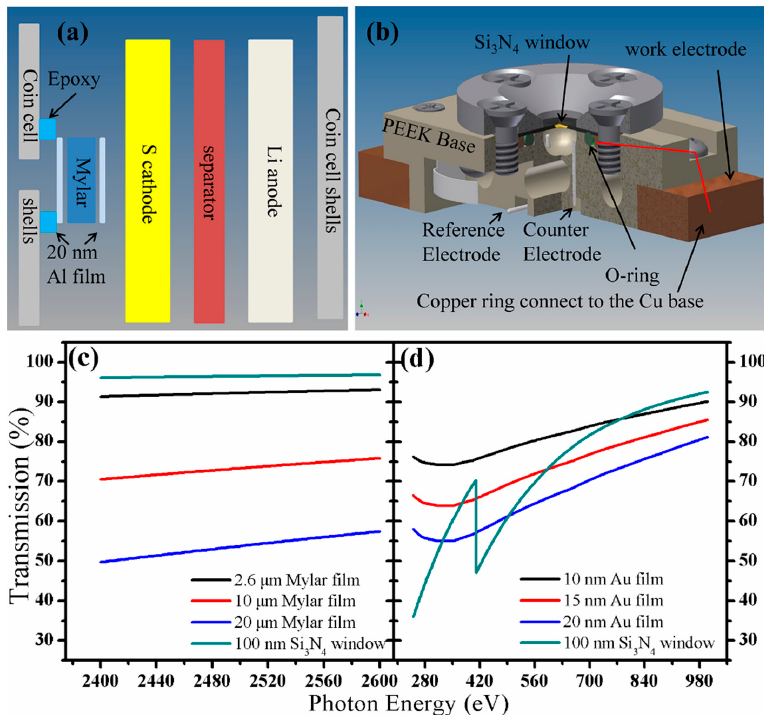
Figure 3. The scheme of ( a ) a modified coin cell and ( b ) a three-electrode electro-chemical cell (figure adapted from Reference [14]); and X-ray transmission at ( c ) soft X-ray energy region and ( d ) tender X-ray energy region through different materials.